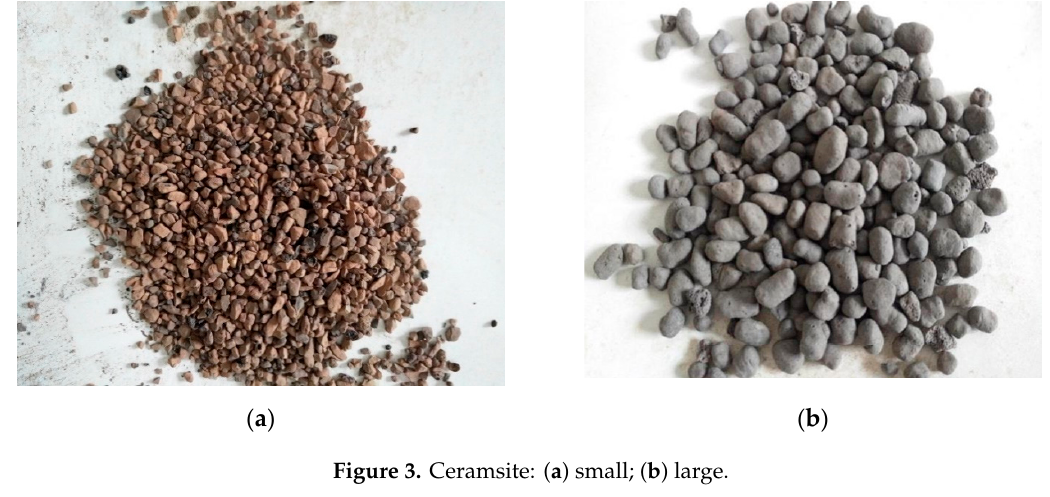
Table 2. The chemical composition of fly ash.